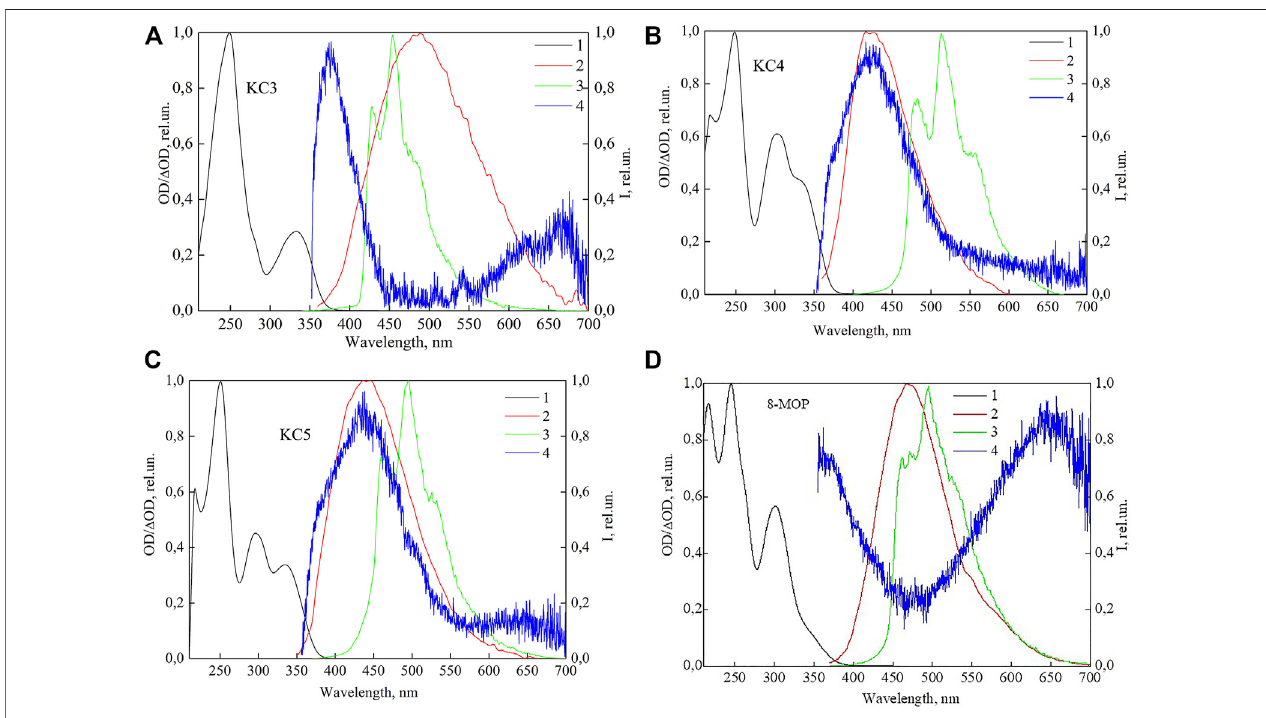
FIGURE 2 | Normalized spectra: 1 — absorption, 2 — fl uorescence, 3 — phosphorescence, 4 — induced absorption for KC3 (A) ; KC4 (B) ; KC5 (C) ; 8-MOP (D) .